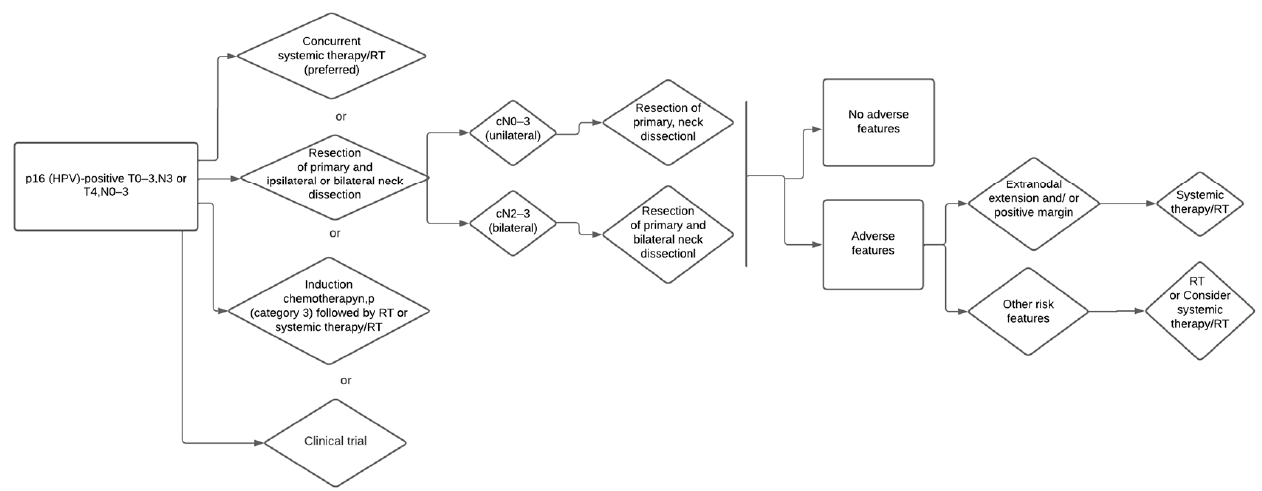
Figure 1. Decisional tree p-16 positive, T0-3 or T4 N0-3.